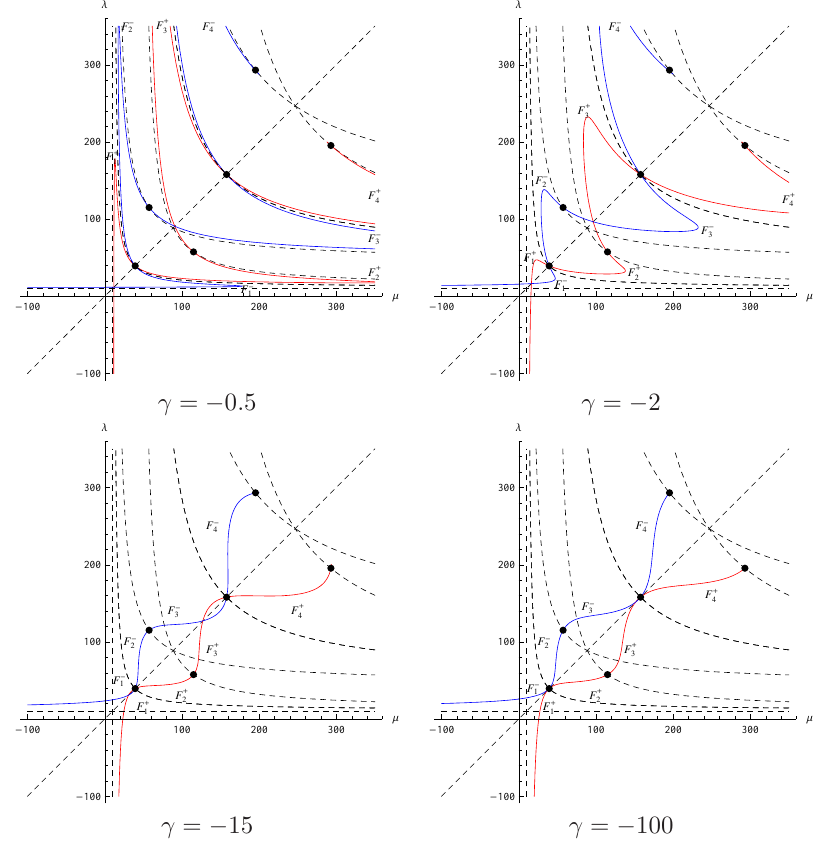
Figure 3. The spectrum for the problem (1.1), (1.4) for different γ values.